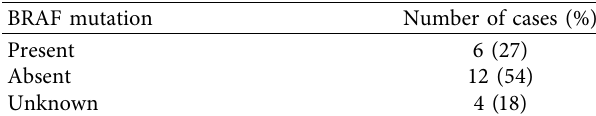
Table 2: BRAF mutation status.